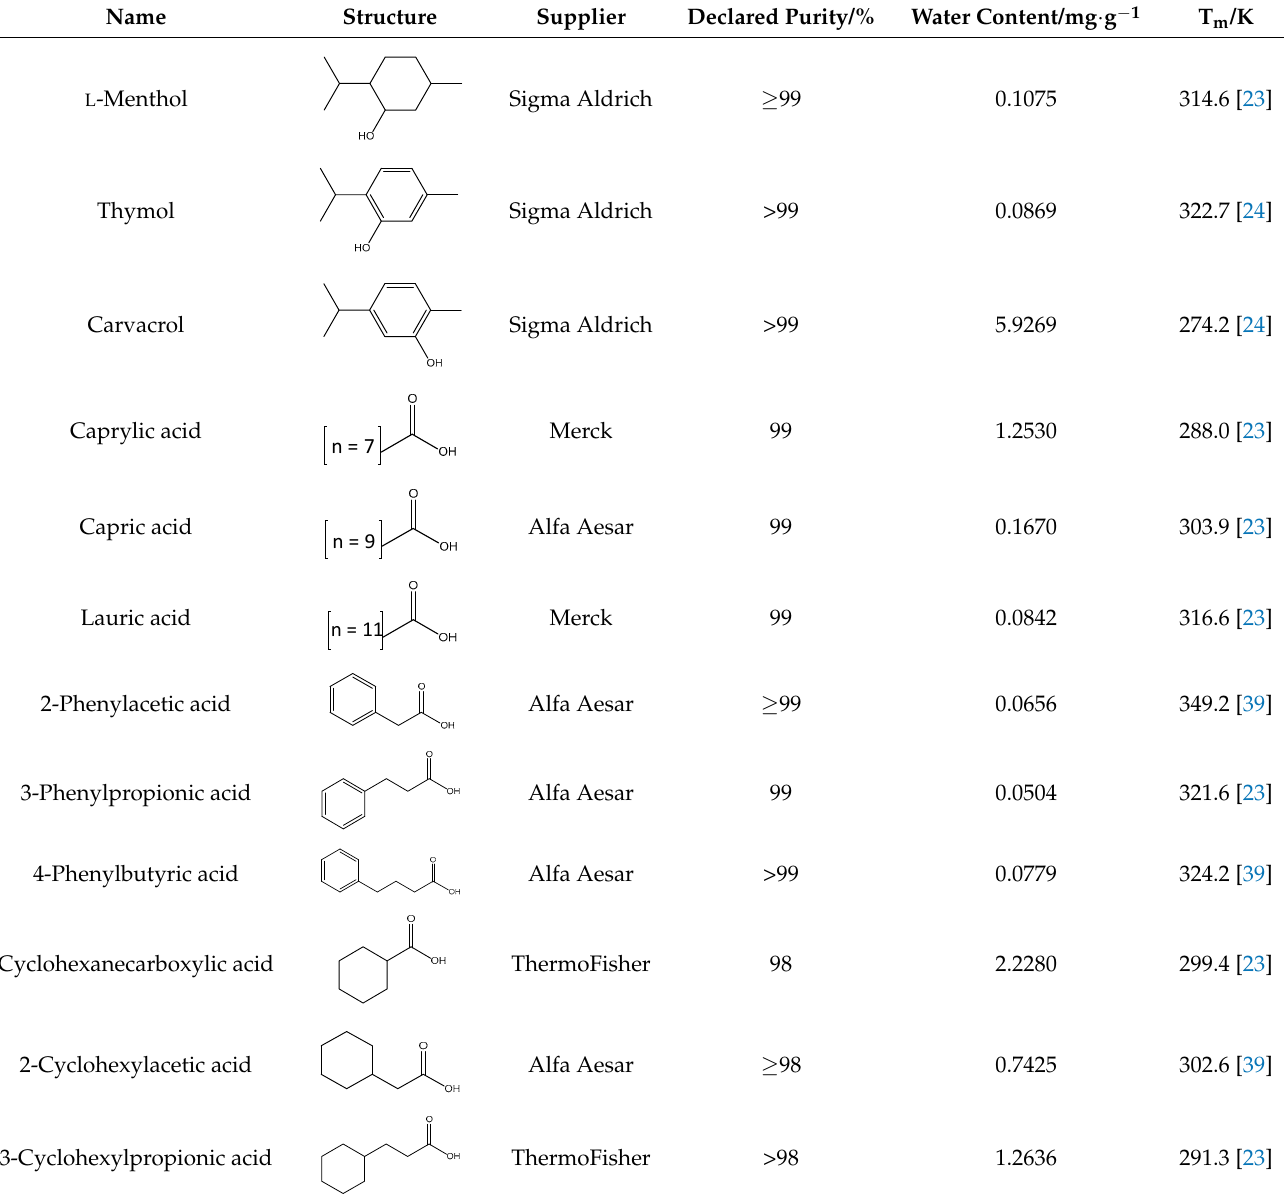
Table 1. Substances used to prepare the eutectic mixtures along with their structure, source, purity, water content, and melting temperature (T m ).